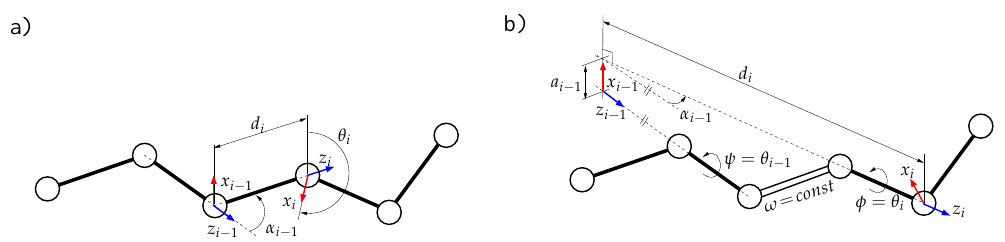
Figure 10. Geometric model of the protein backbone: ( a ) in a general case; ( b ) in the particular case of a rigid peptide bond. In the general case, the mDH parameters involved in the homogeneous transformation matrices between consecutive atom groups are obtained directly from bond lengths and bond angles. In the case of a rigid peptide bond, this requiressome (simple) geometric operations. Note that the origin of a frame attached to an atom group does not necessarily correspond to an atom position.